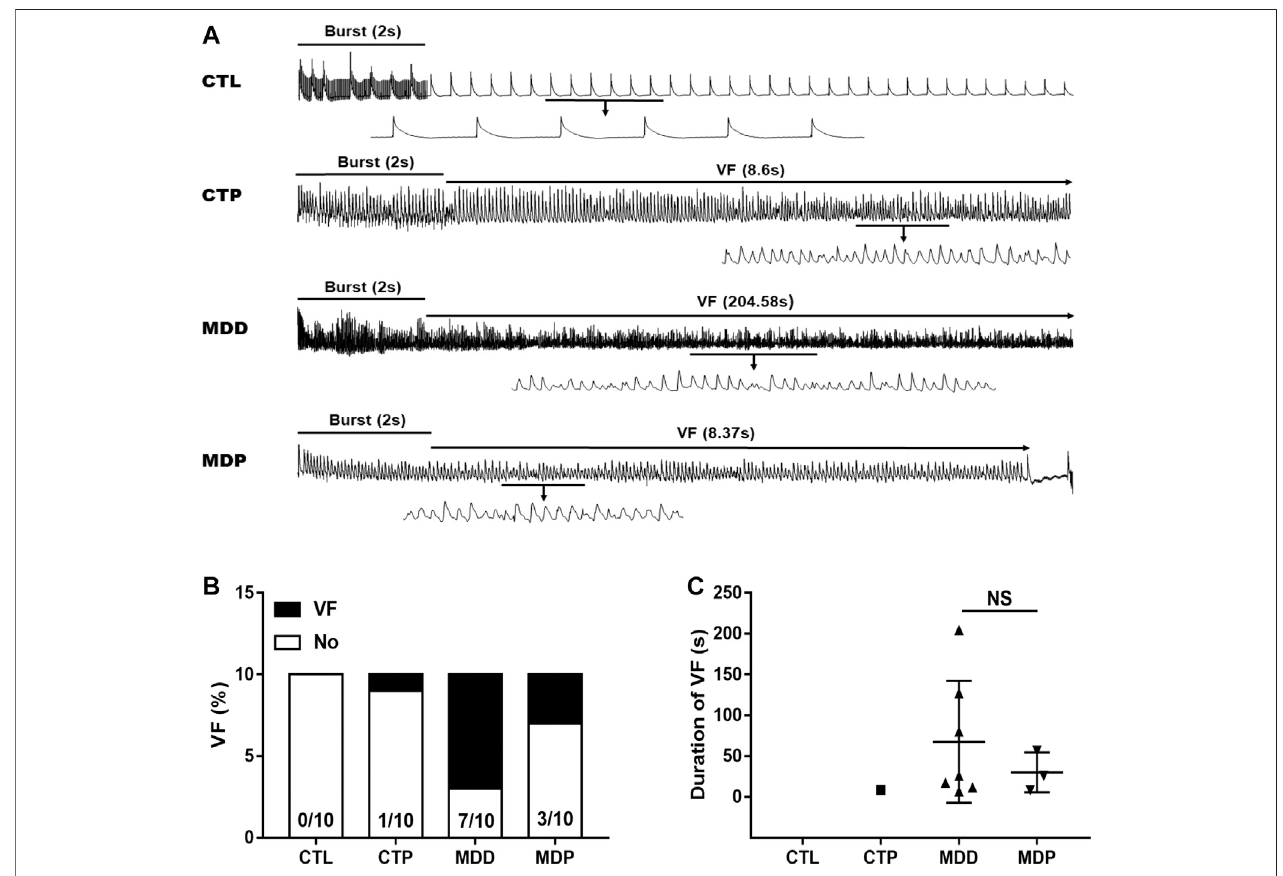
FIGURE 5 | VF vulnerability. (A) Representative recordings of burst pacing protocol. (B,C) Inducibility and duration of VF, respectively. n (cid:1) 10 per group. VF, ventricular fi brillation; NS, no signi fi cant difference.